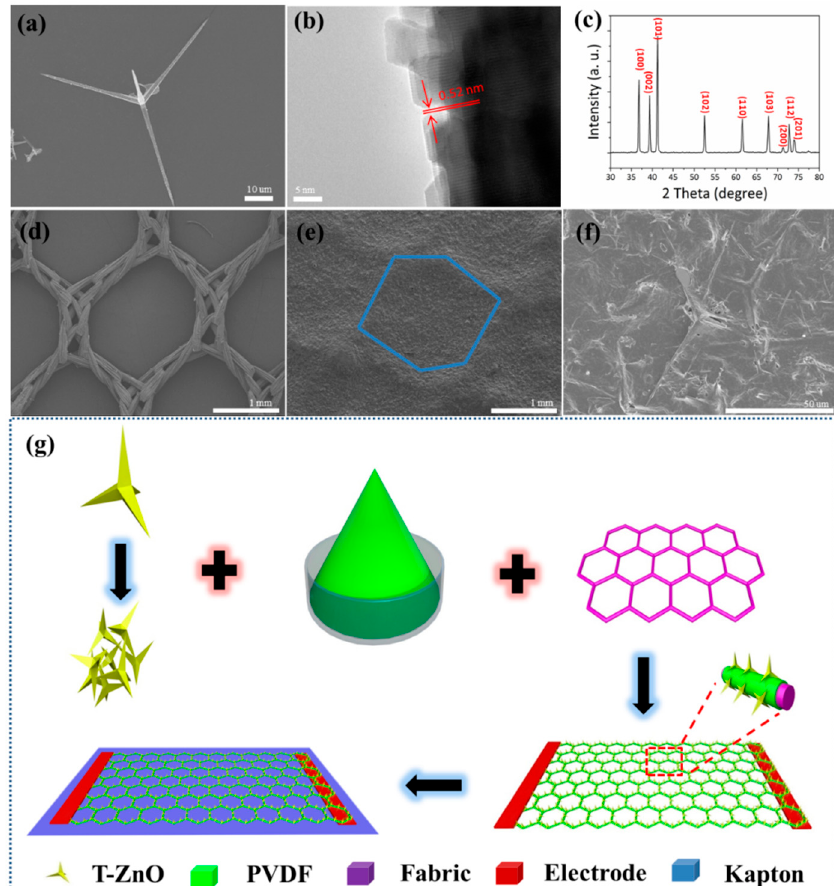
Figure 2. ( a ) SEM image of one single T-ZnO nanostructure. ( b ) High resolution TEM (HRTEM) image of one leg of T-ZnO. ( c ) XRD pattern of T-ZnO. ( d ) SEM image of the textiles (woven fabrics). ( e ) SEM image of T-ZnO / PVDF / fabric. ( f ) SEM image of T-ZnO / PVDF / fabric at high magnification. ( g ) The fabrication